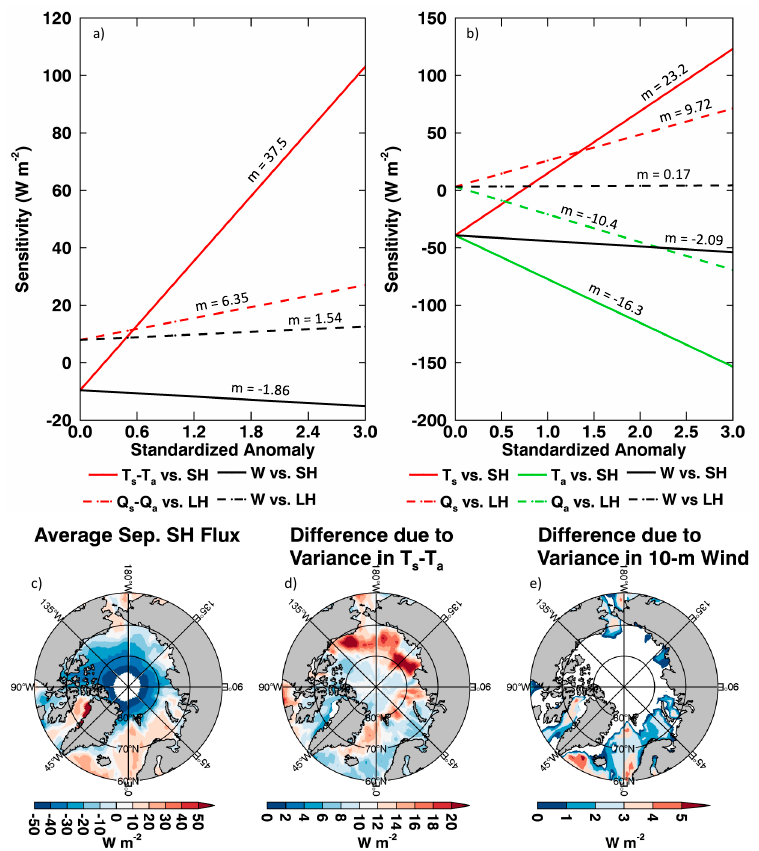
Figure 2. Contributions to SH and LH flux variability illustrates the sensitivity of SH and LH fluxes to changes in T s –T a , q s –q a , and 10-m wind speed. ( a , b ) The perturbation analysis uses AIRS and ERA-Interim reanalysis data and their respective standardized anomalies ranging from 0 to 3 σ . The standard deviations, σ , are computed for the Arctic Ocean domain average between 2003 and 2015. The sensitivity of SH and LH fluxes to the individual terms are quantified in the top, right panel as the line slope, m. ( c ) The average 2003–2015 September SH flux is shown in addition to the spatial distribution of the variance contributions to the September SH flux from individual changes in ( d ) T s –